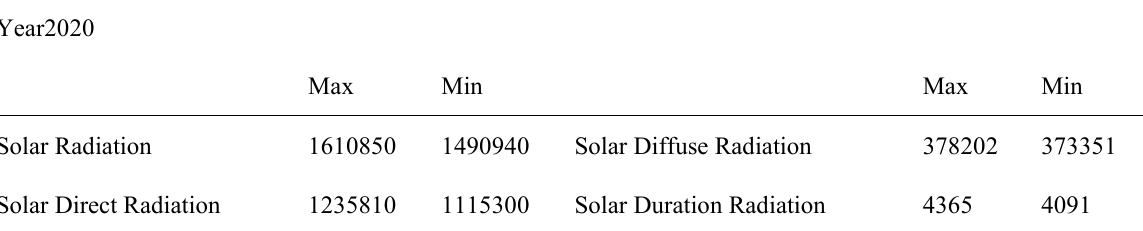
Table 4. The amount of annual radiation in the point cloud